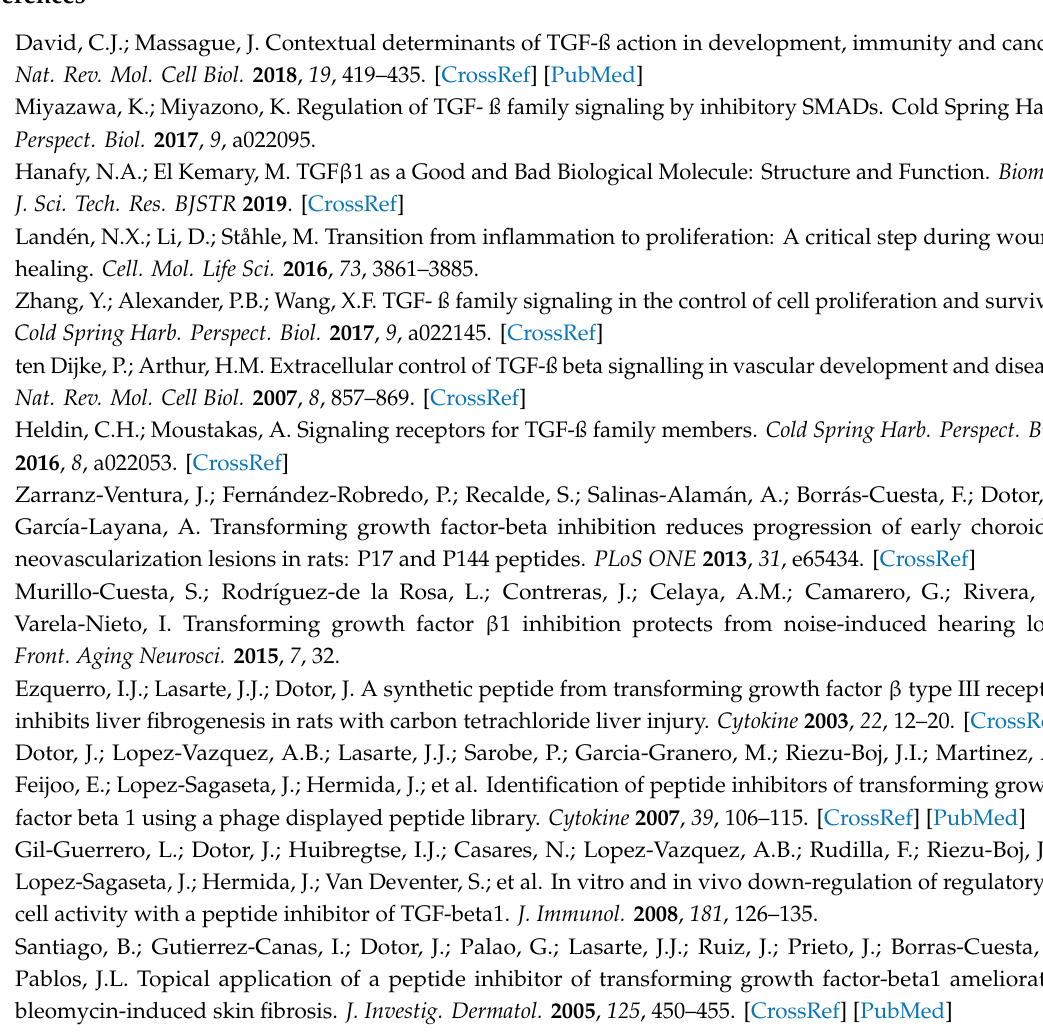
Figure S1: Fluorescence microscopy images for labelled P144, Scheme S1: (A): Folic Acid conjugated carboxymethyl cellulose. (B) Labelling carboxymethyl cellulose with FITC, Scheme S2: Fabrication of protein mucoadhesive targeted